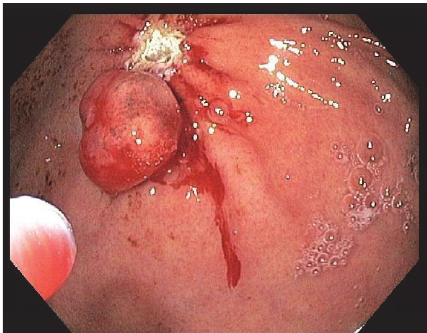
Figure 1: The polypoid lesion was identified as a whitish elevation covered with smooth surface. The polyp was successfully removed with endoscopic resection.